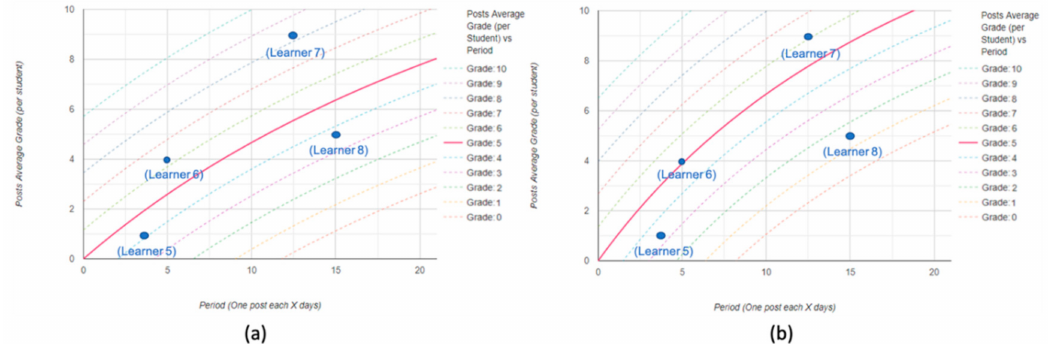
Figure 4. Chart representing f ( x ) plus some other curves calculated through the Euclidean distance to f ( x ) in the range from 0 to 10 points for two values of B : ( a ) high value of B ( b ) low value of B . Scenario ( b ) requires a higher general interaction in the forum by the learner to get the same score.